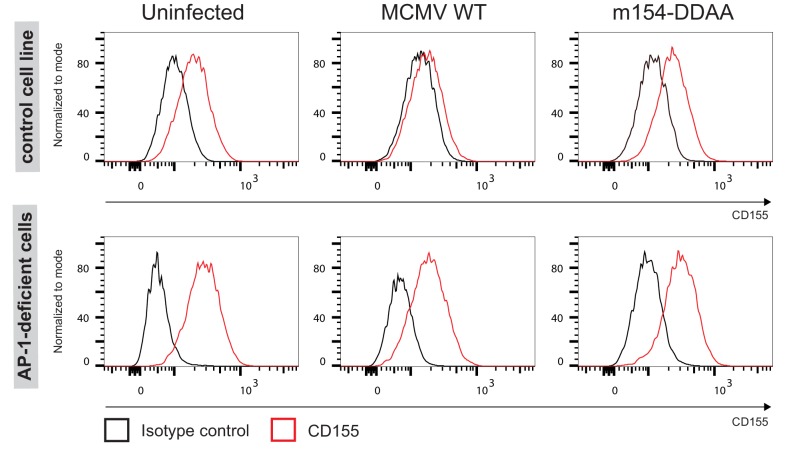
In absence of AP-1 complex, CD155 remains expressed on the membrane of MCMV-infected cells.Flow cytometry analysis of surface CD155 on immortalized mouse embryonic cell lines: AP1µ1A-deficient cell line (AP-1 KO) and the rescued cell line which served as the control cell line, both infected with 3 PFU/cell for 40 h.